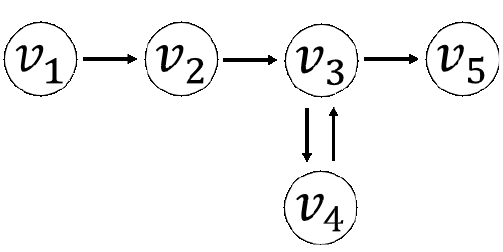
Figure 2. Converted directed